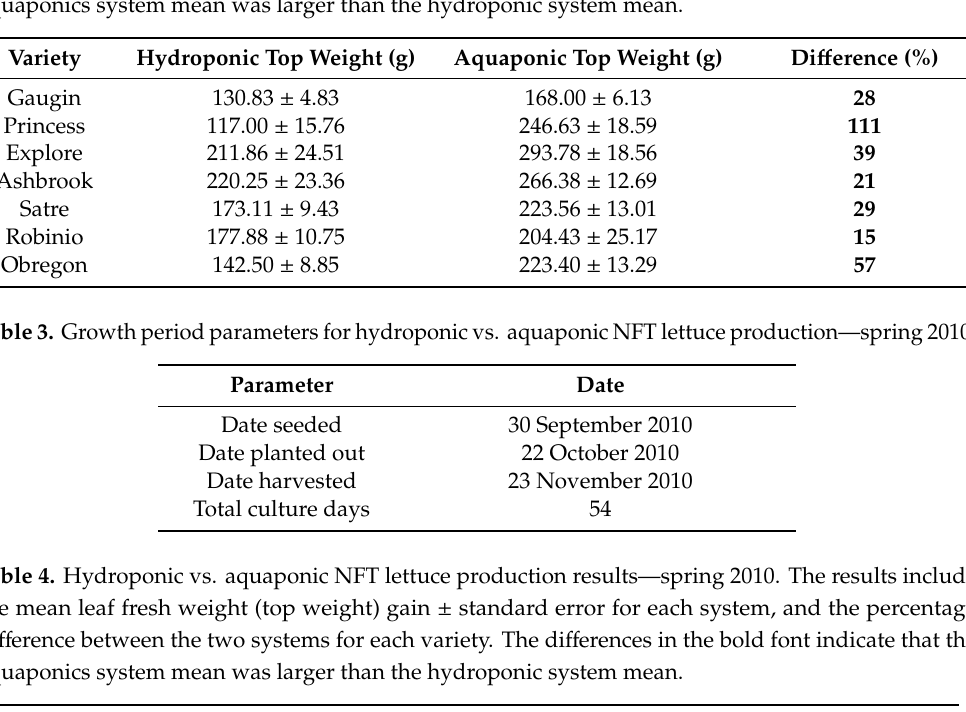
Table 2. Hydroponic vs. aquaponic NFT lettuce production results—summer 2010. The results include the mean leaf fresh weight (top weight) gain ± standard error for each system, and the percentage di ff erence between the two systems for the varieties. The di ff erences in the bold font indicate that the aquaponics system mean was larger than the hydroponic system mean.